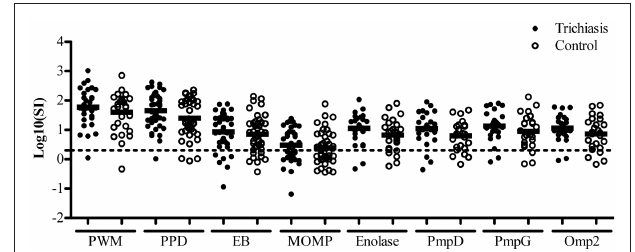
FiGure 1 | Trachomatous trichiasis cases do not differ in proliferative responses to Chlamydia trachomatis antigens compared to